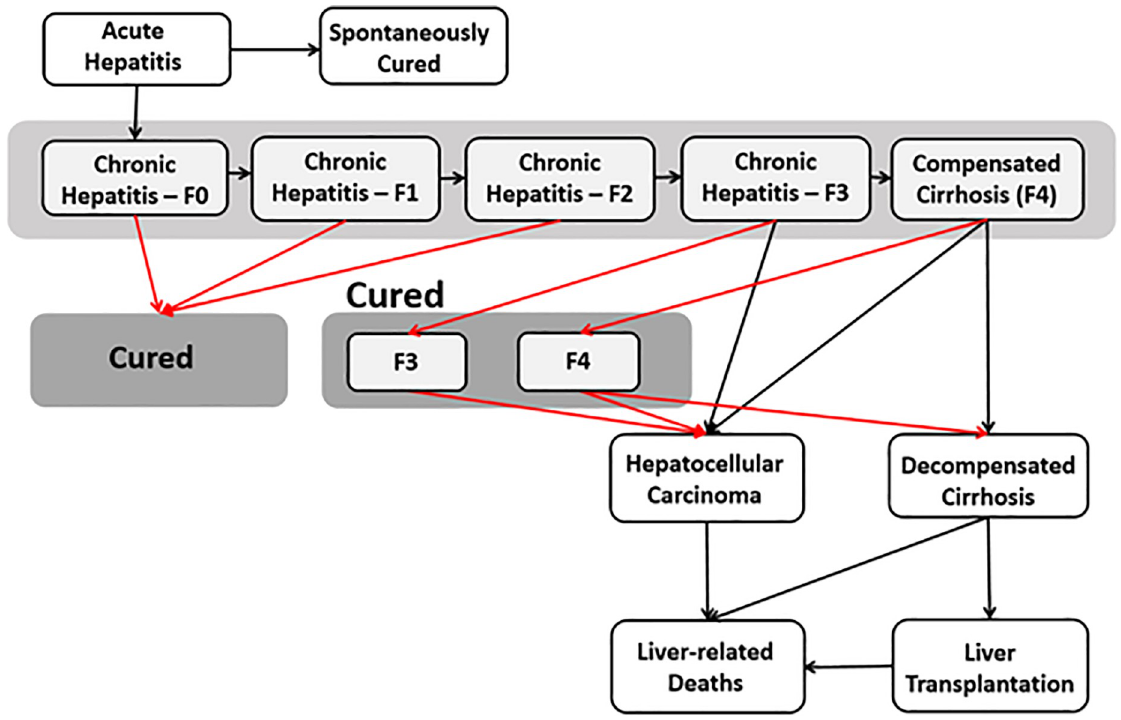
Fig 1. HCV model schematic diagram showing disease progression (black lines: Viraemic, red lines: Cured).